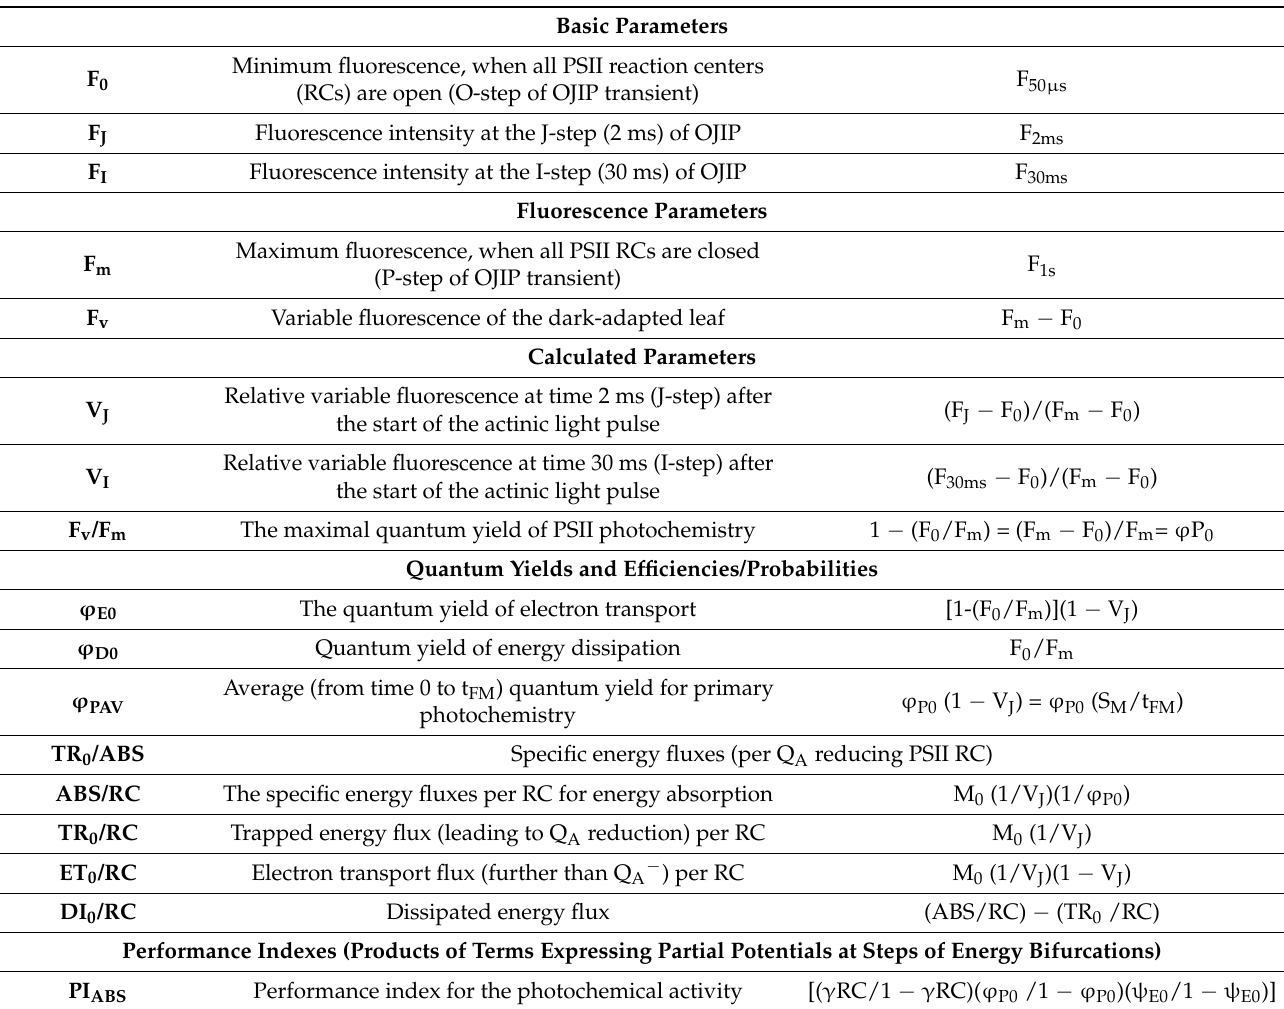
Table 1. The abbreviations, definitions, and formula of OJIP parameters in this study. Basic